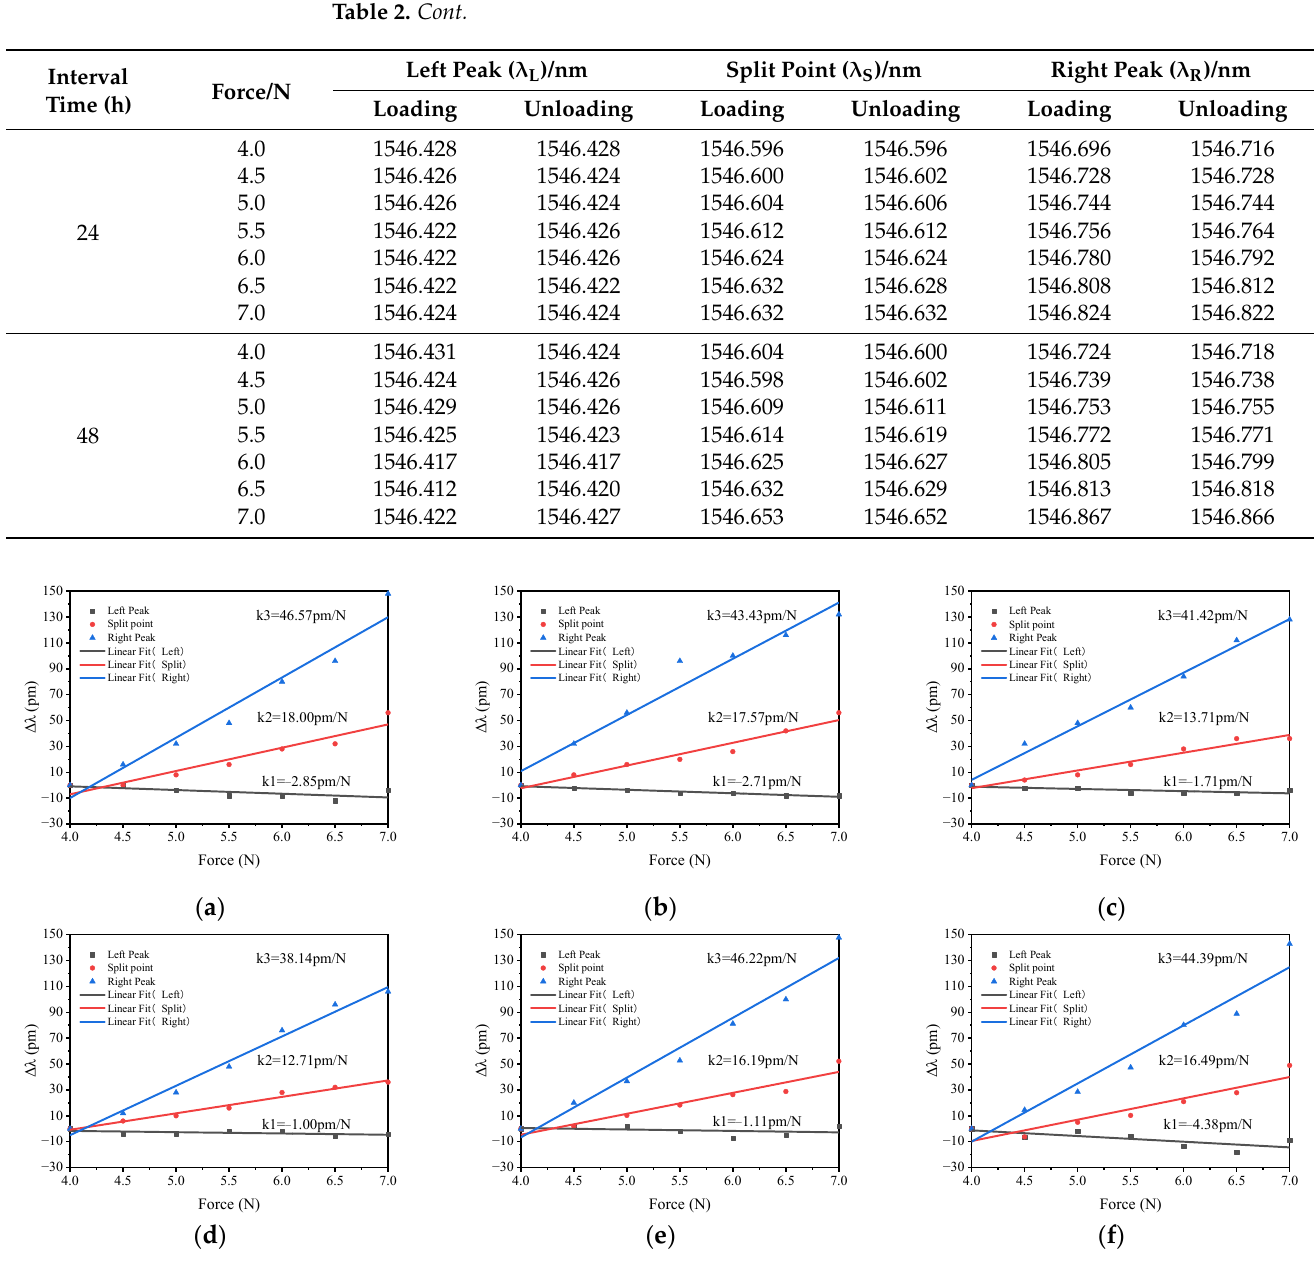
 ,  and  for the FBG relative L S R